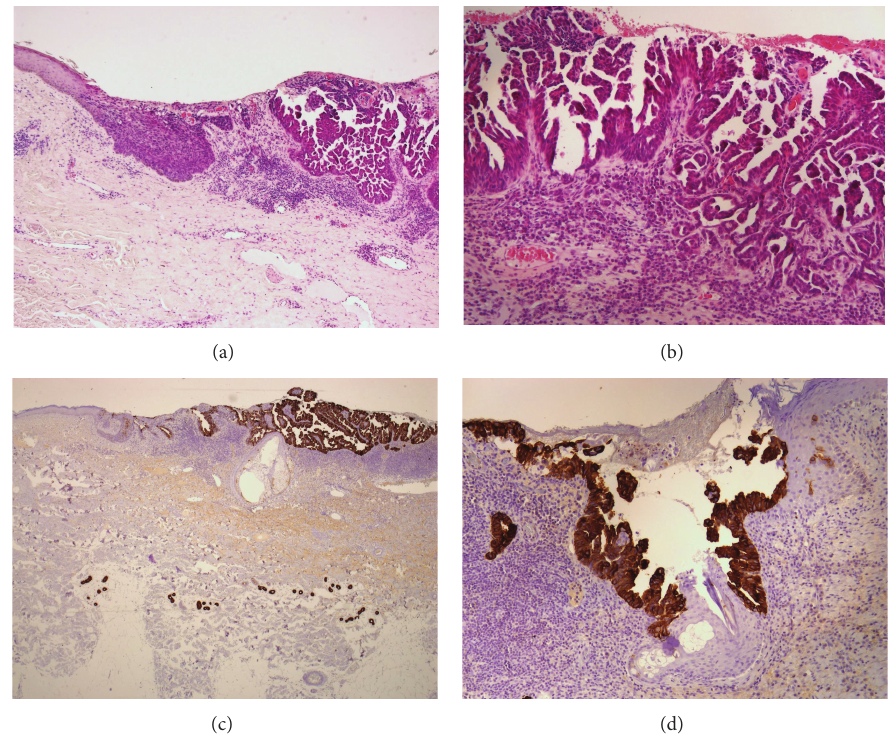
Figure 1: Analysis of a skin syringocystadenocarcinoma papilliferum specimen. (a) Specimen shows squamous cancer cells in the dermis gradually deepening. The squamous budding generates internal cavities giving rise to glandular papillary structures (hematoxylin- eosin [H&E], original magnification × 40). (b) Note the adenopapillary infiltrative structures ([H&E], original magnification × 100). (c) Immunohistochemical staining demonstrates CK7 at the glandular budding forming the papillary components (original magnification × 40). (d) The squamous solid neoplasia persists negative for CK7 (original magnification ×